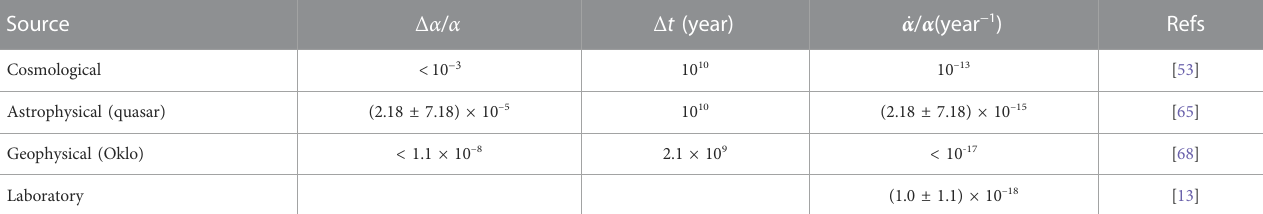
TABLE 3 Comparison of various limits to variation in α with its absolute value ( Δ α / α ) obtained from different types of works over a time interval Δ t . The corresponding limits in annual fractional rate of change ( _ α / α ) , with a crude assumption of a linear change in time, are also given for the purpose of comparing them with the values given in Ref. [76] if one wishes to do